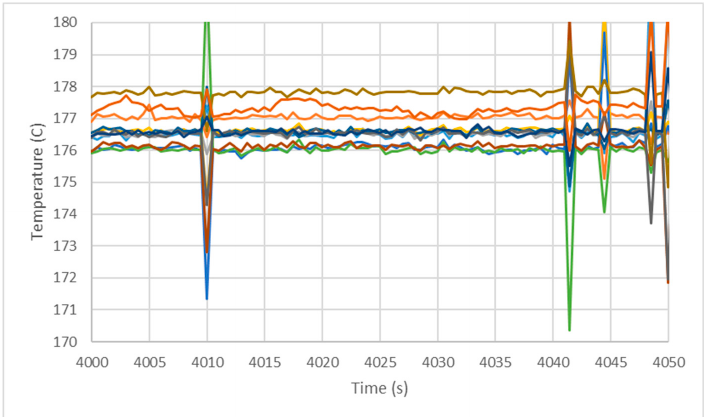
in a furnace. All the thermocouples yielded signal and reacted to the heat pulses in the furnace. Most importantly, the measurements proved to be accurate, within a range of dispersion of 2 ◦